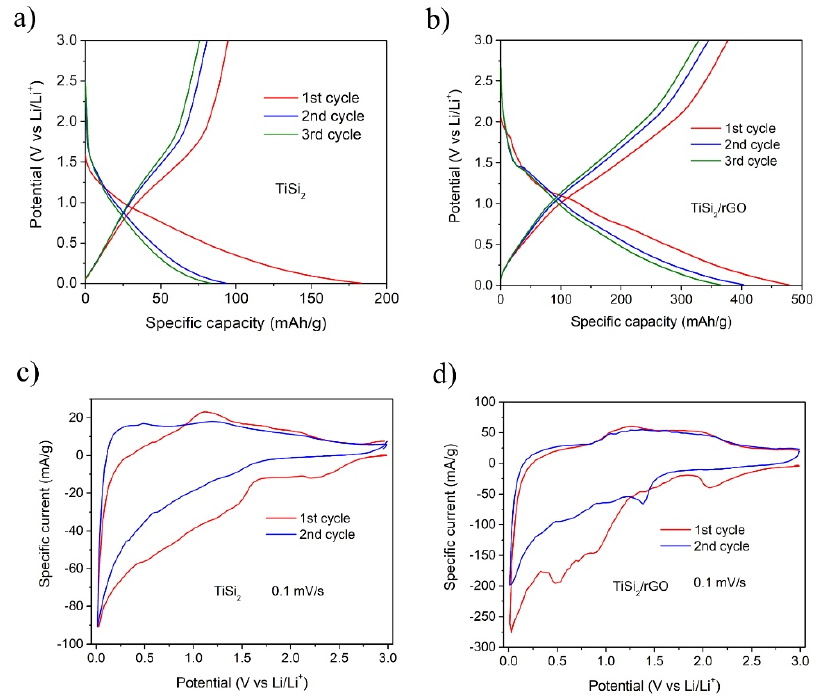
Figure 2. The first three voltage profiles at 50mA/g of ( a ) TiSi 2 and ( b ) TiSi 2 /RGO; CV scans at 0.1 mV/s of ( c ) TiSi 2 and ( d ) TiSi 2 /RGO.